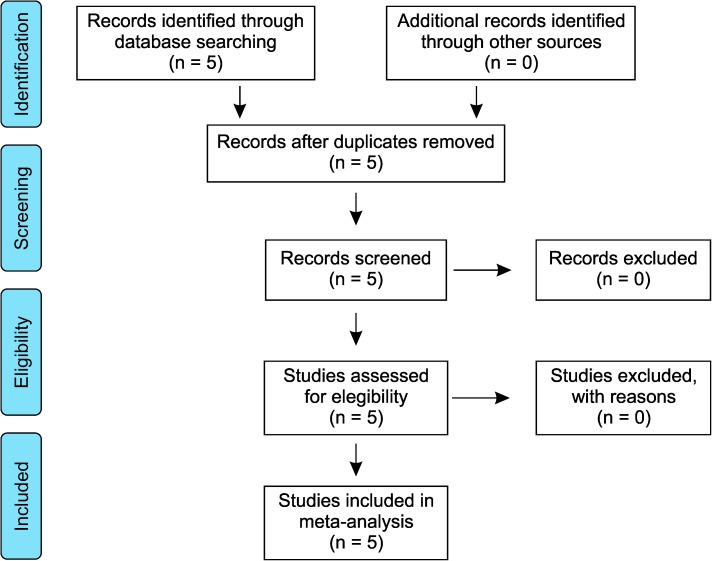
Prisma flow diagram.